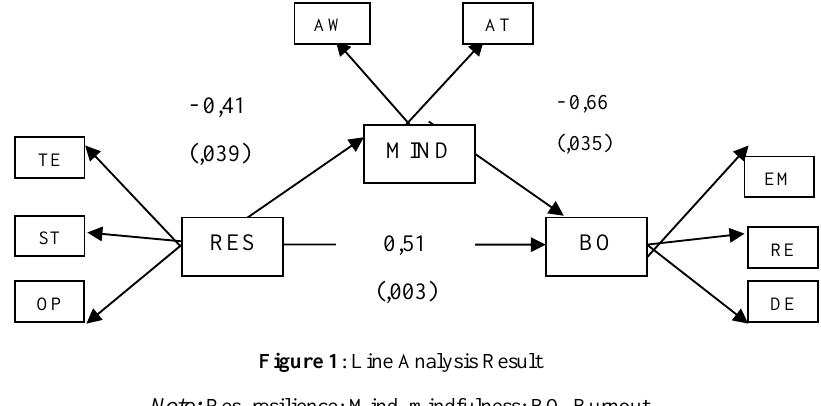
Figure 1 : Line Analysis